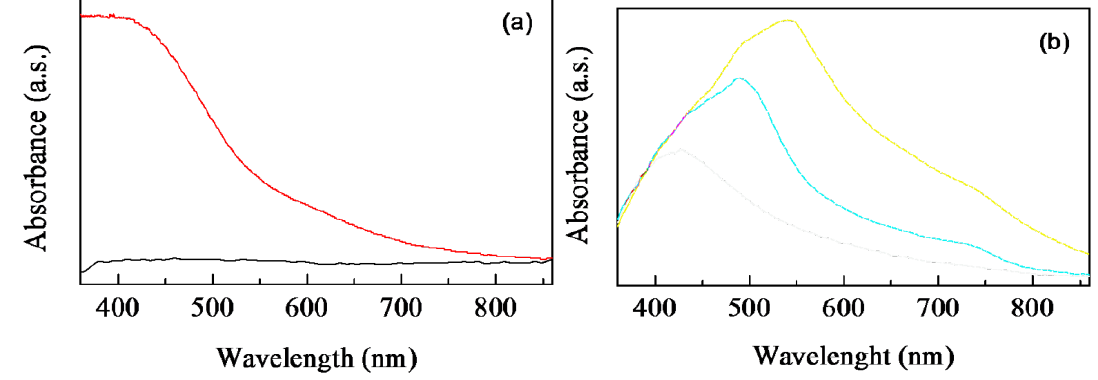
Figure 11. ( a ) Absorbance of a water solution of PAP as prepared (black), and after few weeks ageing in air (red); ( b ) absorbance of Nafion:Cu in a water ethanol mixture before (black), and half one hour after the addition of 10 mM PAP (red). The blue line is the steady state absorbance of the same Nafion:Cu solution with 10 mM PAP, after two hours of staying in